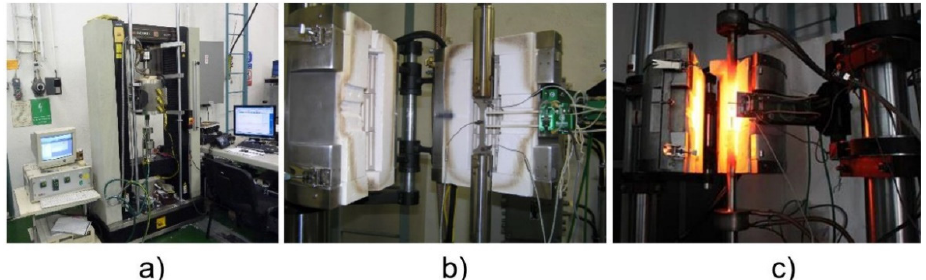
Figure 14. Static uniaxial tension test at the elevated temperature: test cell ( a ); test sample prior ( b ); and after ( c ) the test.